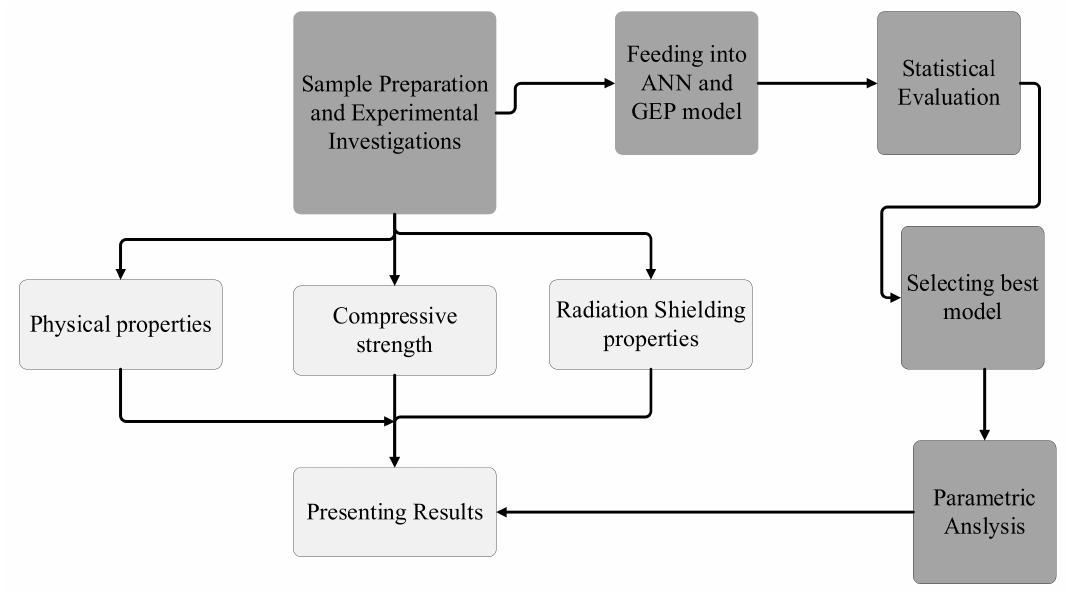
Figure 1. Flow diagram of the undertaken